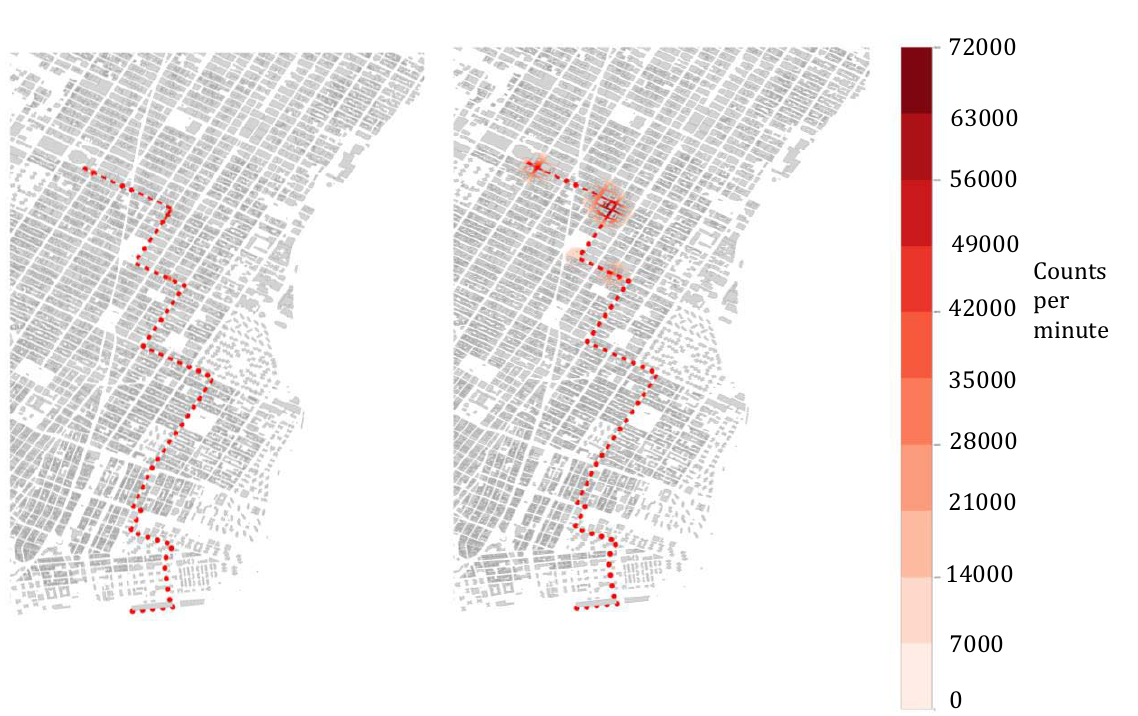
Figure 4. Detection heat maps. Maps show counts per minute detected for a 400-vehicle mobile detector array of a 0.1 Ci Co-60 (left) and a 0.5 Ci Co-60 (right) source moving at